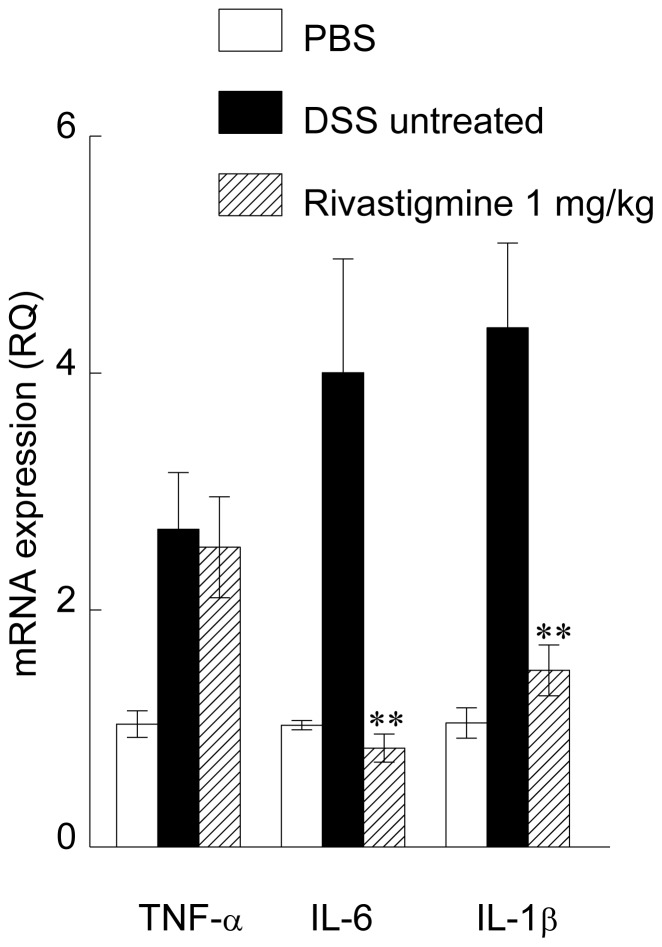
mRNA of pro-inflammatory cytokines in colon of mice with DSS- induced colitis.Legend as in Figure 3. Data are mean ± SEM and represents pooled data from 9–10 mice per group. Significantly different from mice with DSS-induced colitis treated with PBS, ** p<0.01.